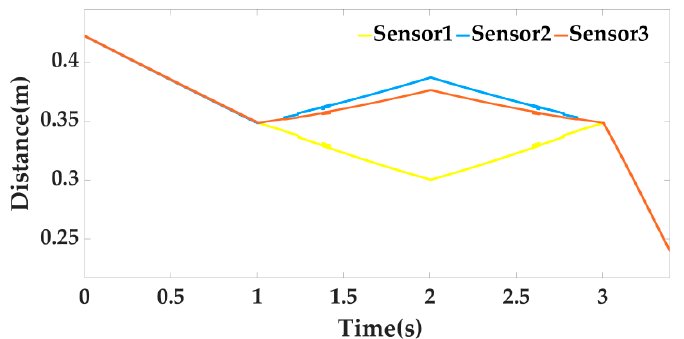
Figure 13. Distance of three laser sensors.